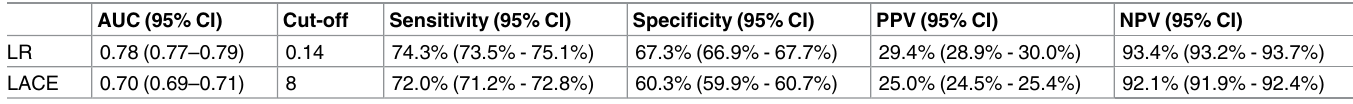
Table 3. Prediction results by the multivariable logistic regression (LR) model using receiveroperating characteristic (ROC) analysis. AUC (95% CI)